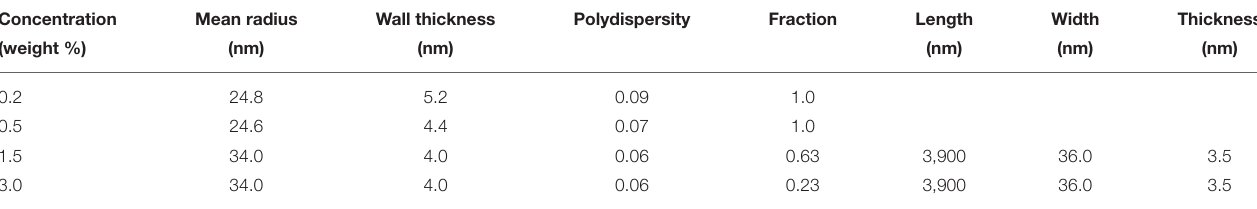
TABLE 1 | Model parameters from the SAXS analysis of A β (16-22) peptide samples shown in Figure 2A . Concentration Mean radius Wall thickness